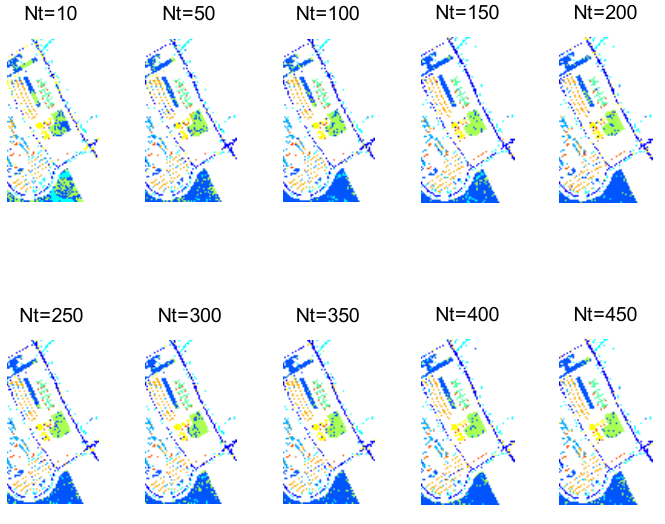
and different (cid:13) for Indiana dataset 4 = 16 3